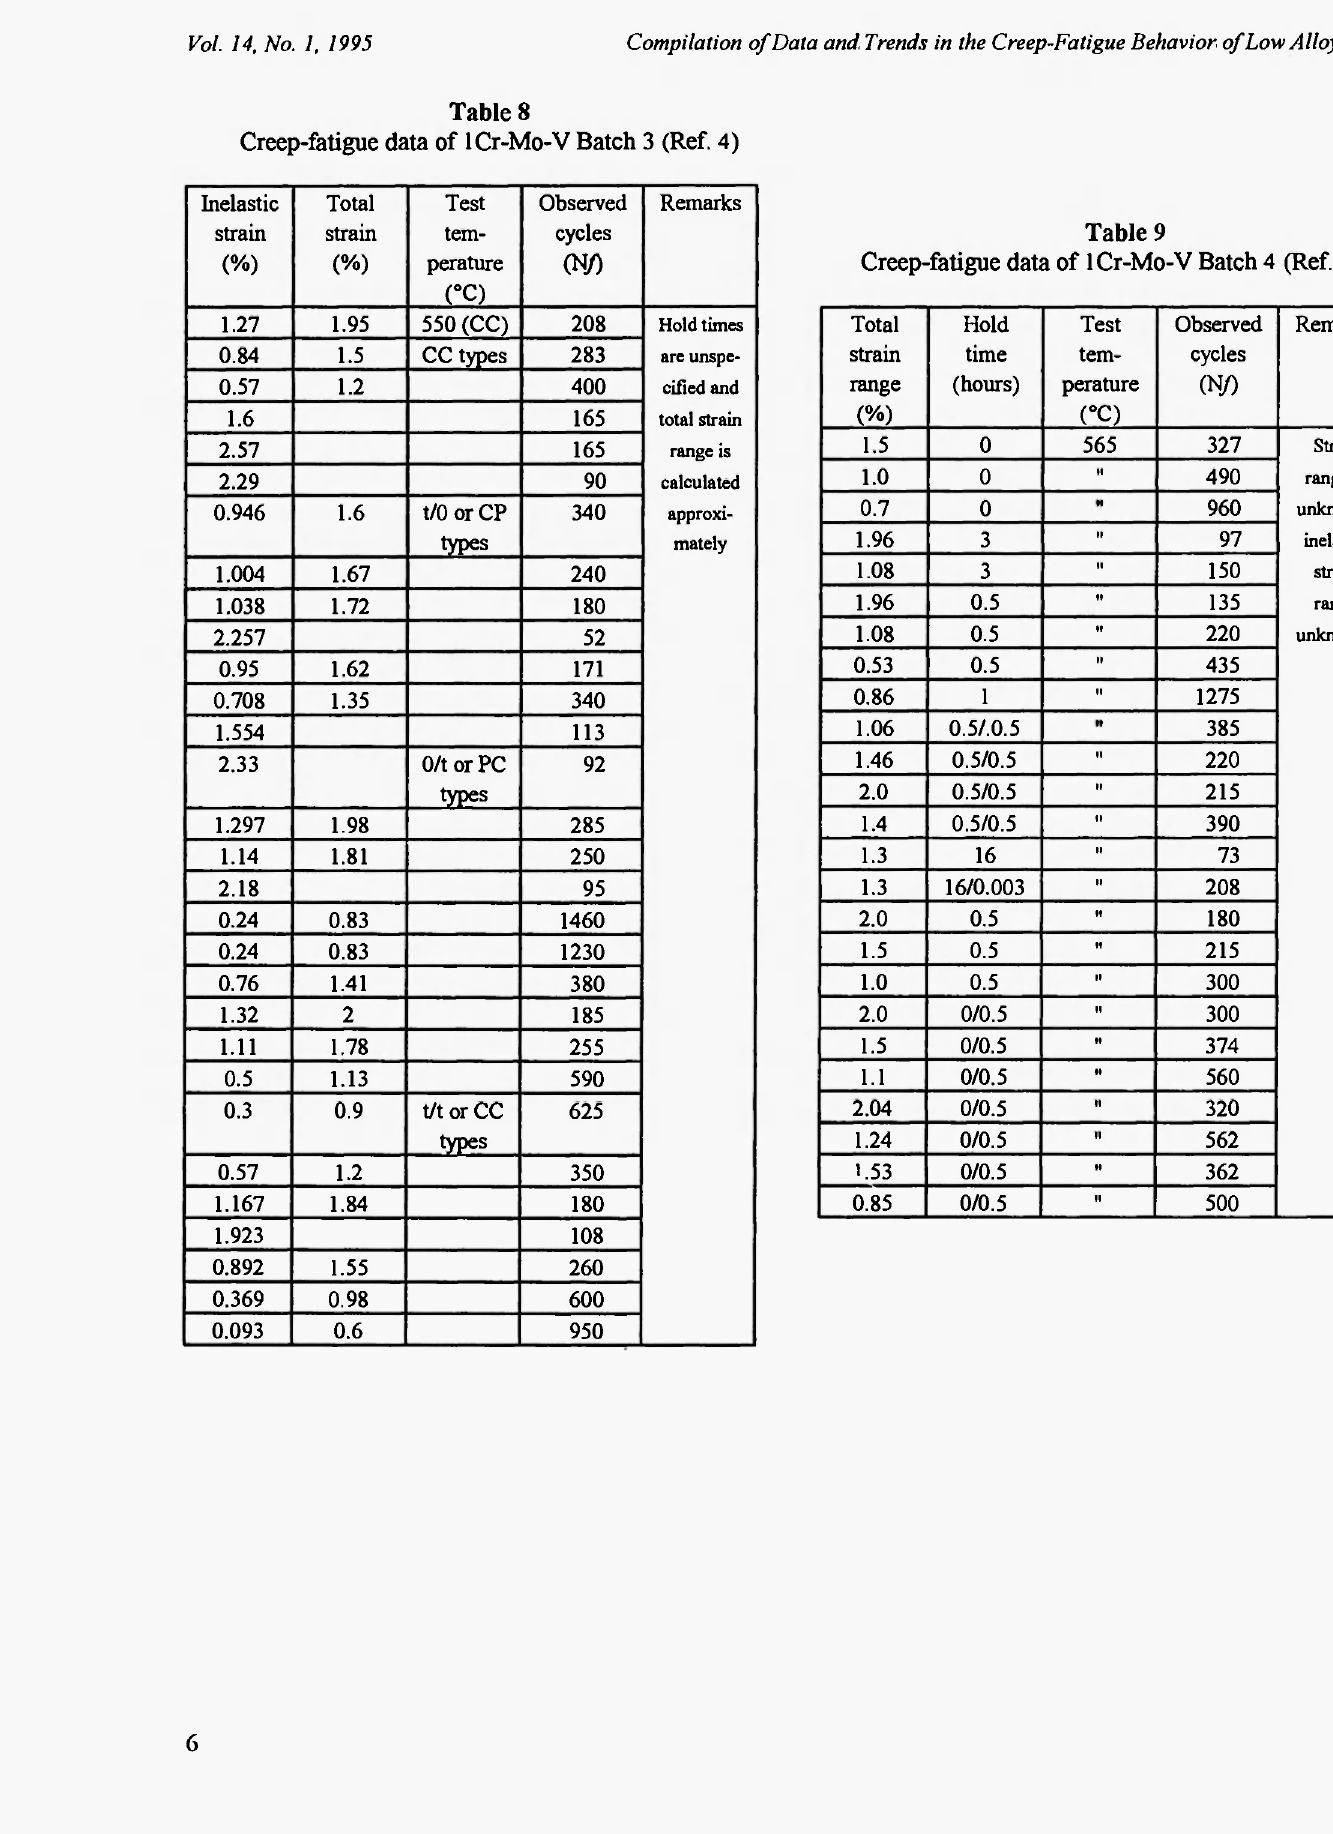
Creep-fatigue data of lCr-Mo-V Batch 3 (Ref. 4)